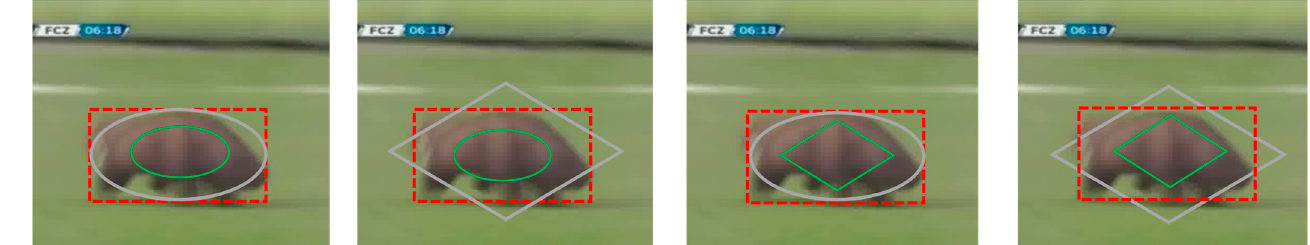
Figure 12. Four different sample label combinations: Ellipses, rhombus-ellipse, ellipse-rhombus, and rhombuses. Specifically, the labels ② and ③ , which consist of ellipse and rhombus, perform a little bit better than the ellipse labels. On the whole, the rhombus labels have the best per- formance compared to the other three label shapes. It indicates that our rhombuses labels can debase interference of the error-prone sample and get a more noiseless classification.